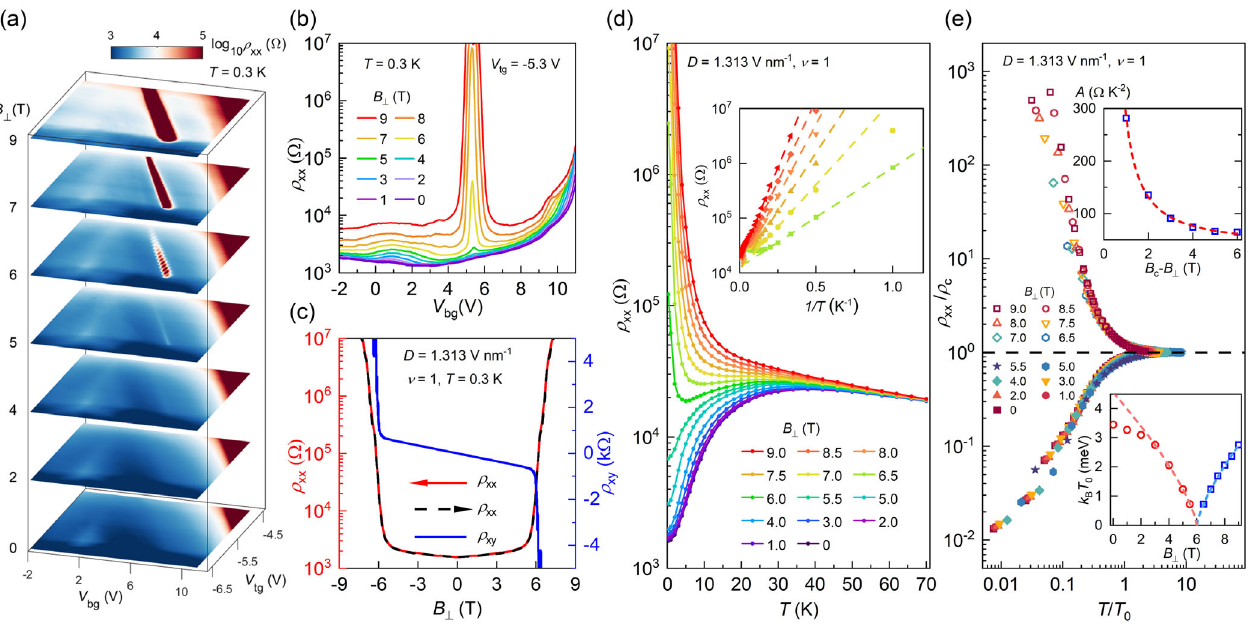
FIG. 3. Magnetic-field-induced metal-insulator transition. (a) Evolution of the insulating state at half filling as a function of out-of- plane magnetic field B ⊥ . Each color plane shows the ρ versus top and bottom gate voltages at a fixed B ⊥ . (b) Showing V sweeps of xx bg ρ ¼ − 5 . 3 V under varying B ν ¼ 1 above the critical magnetic field B ≈ 6 T. (c) Red at a fixed V ⊥ . Sharp resistance peaks occur at xx c tg (dashed black) and blue curves show ρ and ρ as functions of B ⊥ at 0.3 K, respectively. The gate voltages are fixed to ensure ν ¼ 1 xx xy and D ¼ 1 . 313 V nm − 1 , the same for (d) and (e). No hysteresis is observed upon sweeping down and up the magnetic fields (indicated by the red and dashed black arrows, respectively). (d) Temperature dependences of ρ at different B ⊥ , showing the magnetic-field- xx induced MIT. Inset: Dashed lines represent Arrhenius fits to extract activation gap magnitudes for B ⊥ > 6 T. (e) Quantum critical ¼ ρ ð B ¼ B Þ ] curves neatly collapse onto two branches that are almost scaling analysis of the MIT. The normalized resistance [by ρ c xx c “ mirror symmetric, ” with one showing an insulating behavior and the other showing a metallic behavior. The determination of the scaling temperature T 0 is discussed in the main text. Top inset: magnetic field dependence of A , where A is the fitting parameter for the − B Þ − 0 . 98 (cid:3) 0 . 11 . Bottom inset: the scaling parameter k T 0 low-temperature Fermi liquid. The dashed curve is a power-law fit A 1 = 2 ∝ ð B ⊥ c B j ≤ ∼ 3 T), both sides show power-law versus B ⊥ on both sides of the critical field (red and blue open symbols). Close to B ( j B ⊥ − B c c dependences with critical exponents 0 . 73 (cid:3) 0 . 02 (red and blue dashed